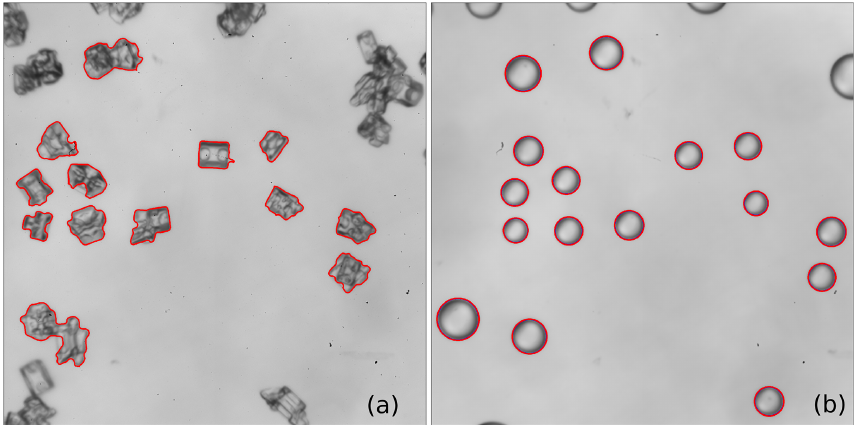
Figure 4. Sample images of ice crystals collected on a microscope slide before and after melting. The automatically detected contours (from k -means clustering segmentation (Pedregosa et al., 2011) in the crystal image and from Hough circle detection (Hough and Paul, 1962) in the droplet image) are added in red. Contours which intersect the image frame borders are discarded.